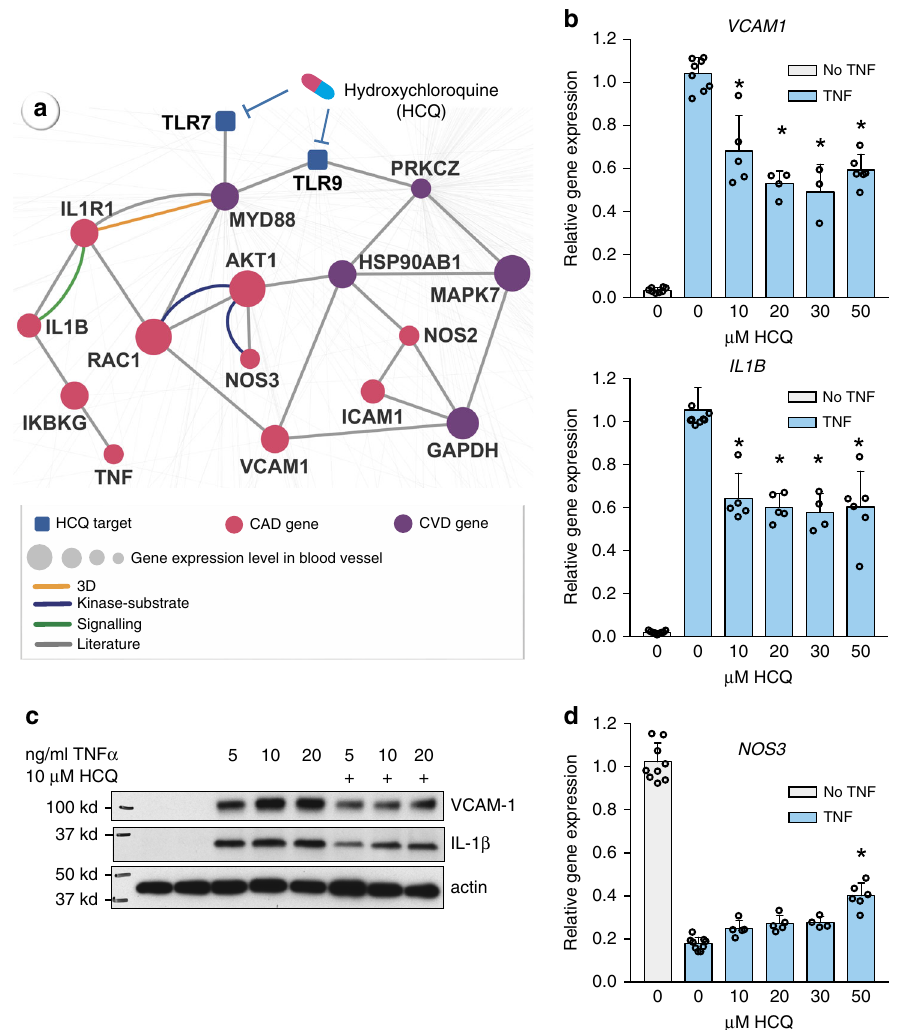
Fig. 4 Experimental validation of hydroxychloroquine ’ s likely mechanism-of-action in coronary artery disease (CAD). a A highlighted subnetwork shows